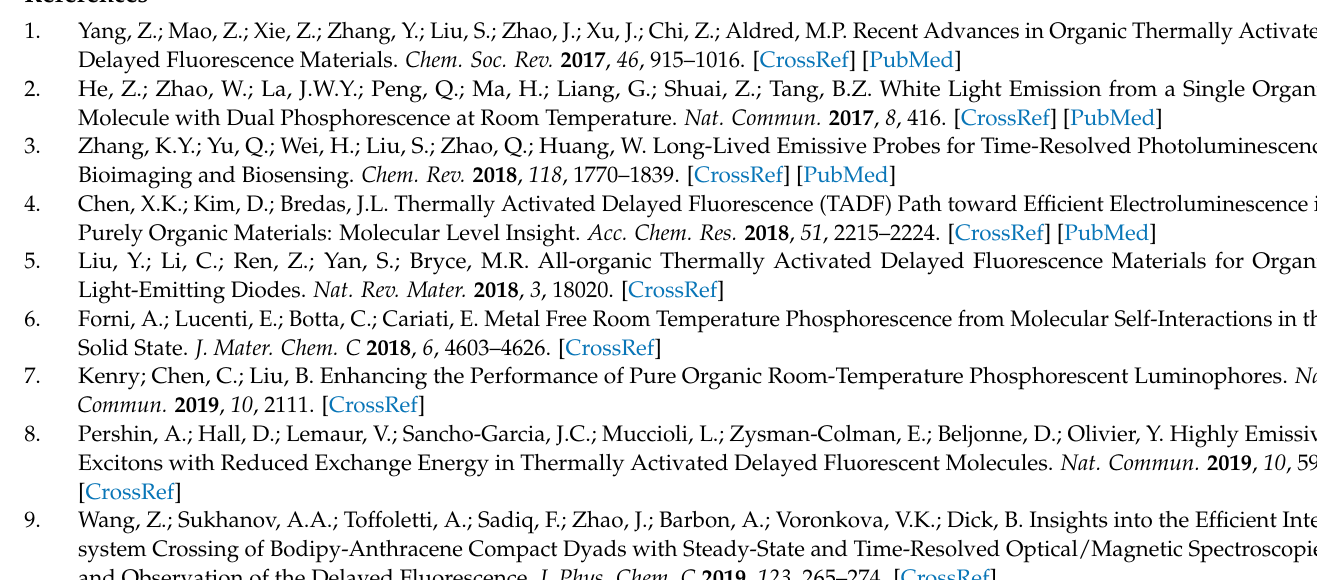
Figure S3: Time-resolved emission spectra at different delay times (in µ s) after laser excitation at 355 nm of PM546 (left) and PM597 (right) in aerated ethyl acetate solution at room temperature; Figure S4: Comparison of the time-resolved emission spectra of PM650 in different solvents (toluene (A), ethyl acetate (B), acetonitrile (C) and DMSO (D)) upon laser photoexcitation at 532 nm. The measurements were carried out in aerated solutions at room